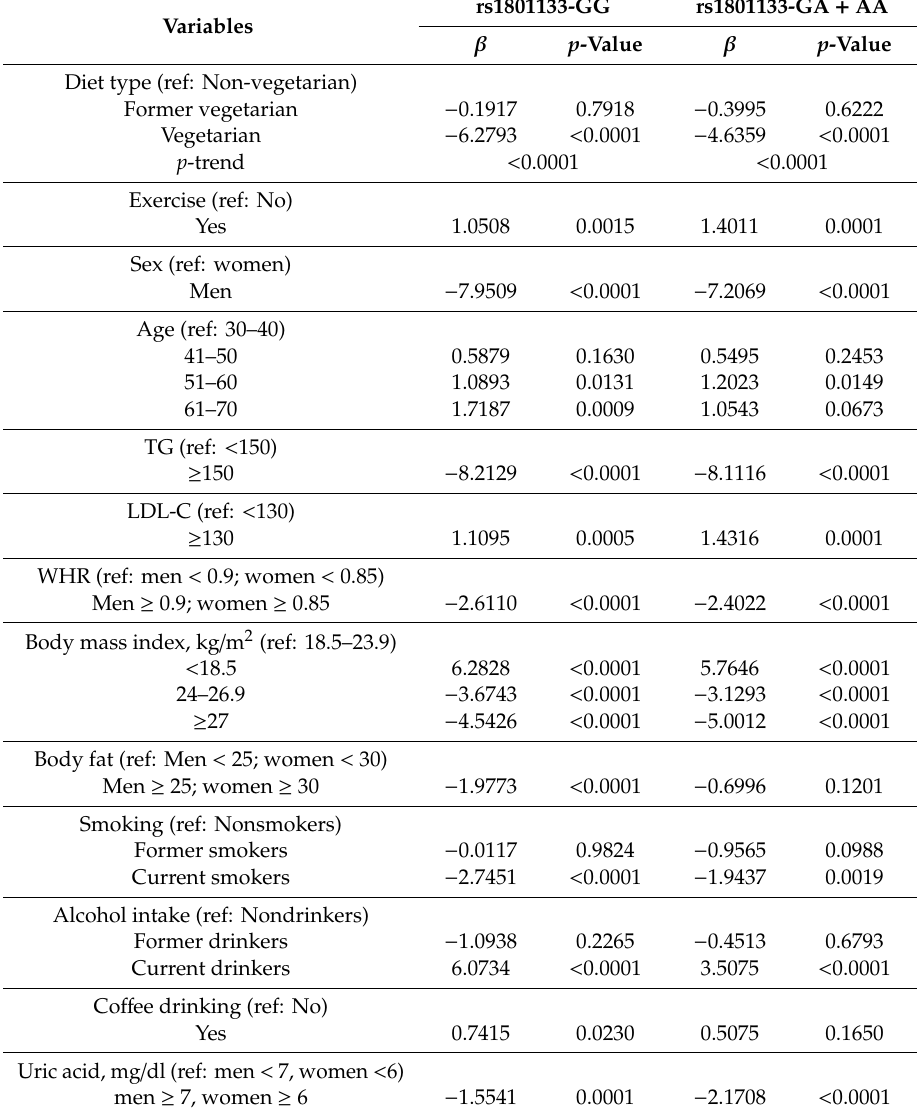
Regression coe ffi cients of lifestyle variables associated with HDL-C according to rs1801133